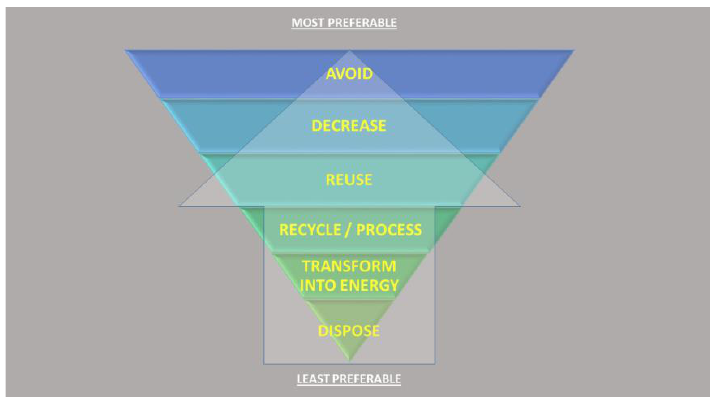
Figure 1. The hierarchy of waste disposal. With reference to the increase in food demand, shell waste could only be considered from the point of reuse down to dispose, as adapted from the European Commission’s Green Growth and Circular Economy package of the Europe 2020 Strategy